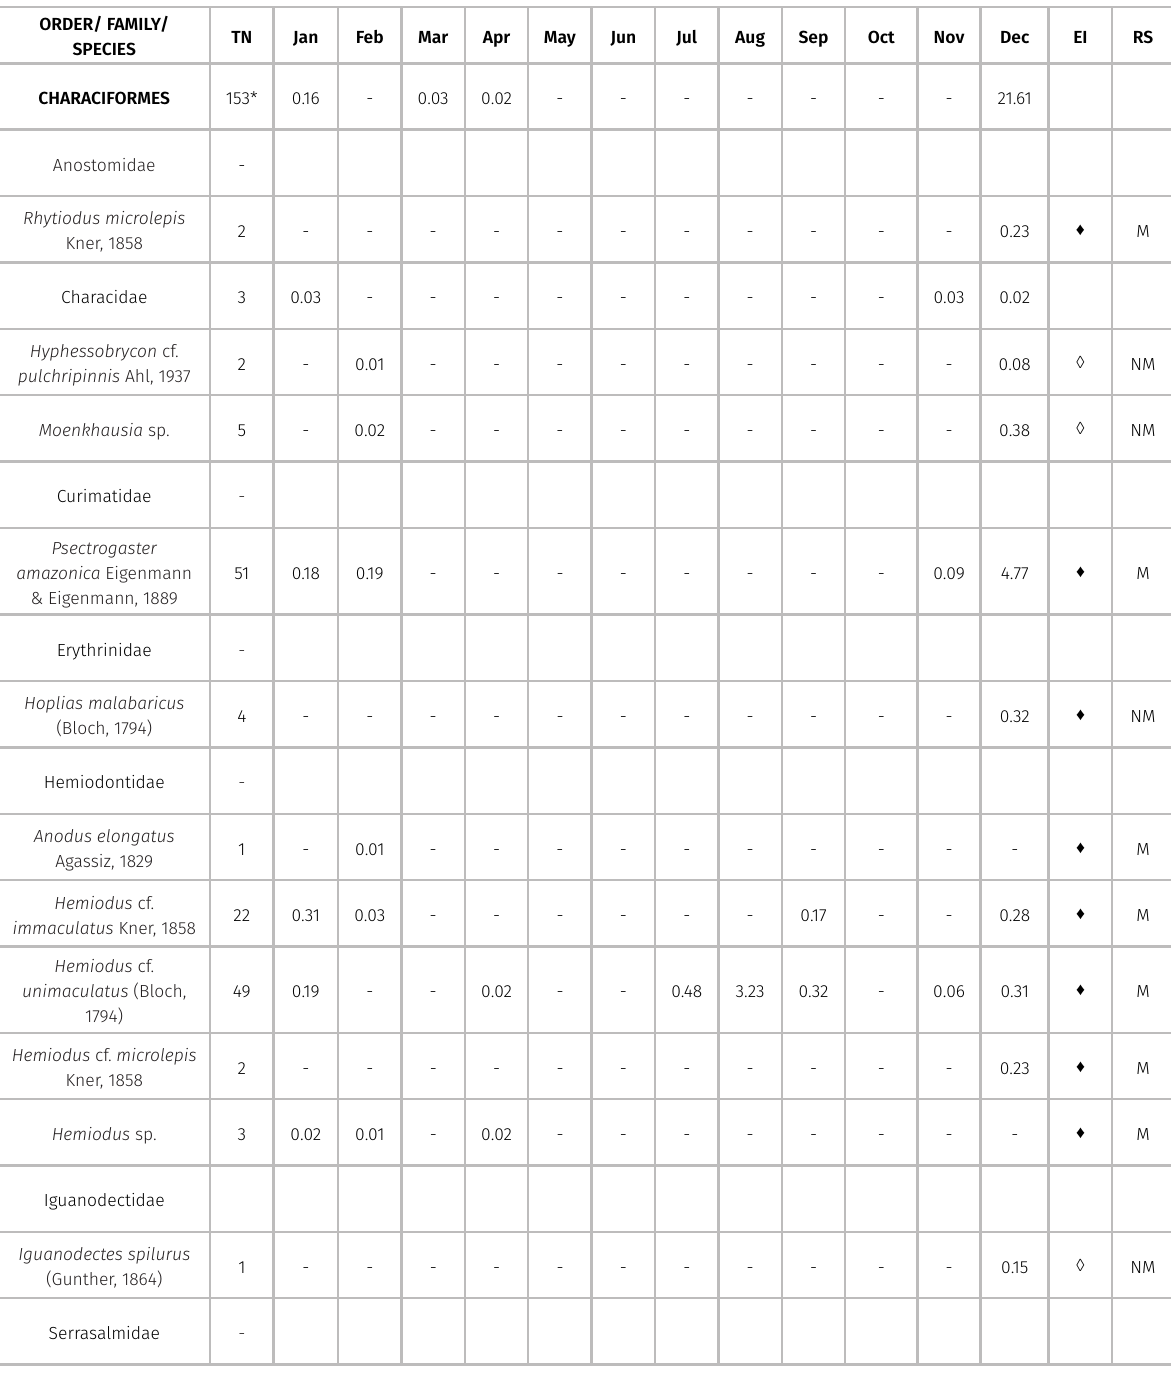
Table I. Taxonomic composition, total abundance and monthly variation of the density of ichthyoplankton collected in Lake Juá, during samplings from September 2017 to August 2018, at the mouth of the Tapajós River, state of Pará, Brazil. EI: economic importance. ( ♦ ) Marketed in regional marts and fairs. (◊) Ecological importance in the ecosystem. TN: total number. RS: reproductive strategy. M: migratory species. NM: non-migratory species. *Yolk-sac stage